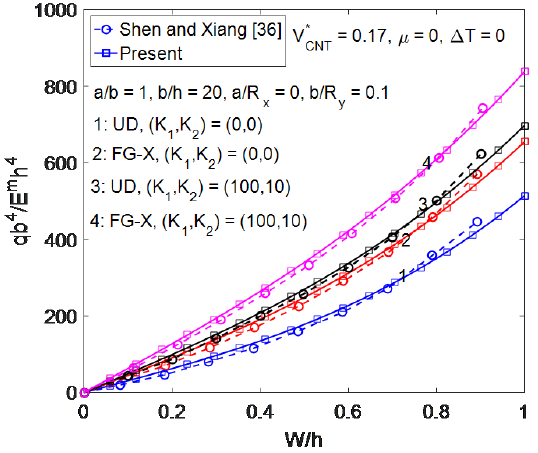
Fig. 2: Comparison of load-deflection response for CNTRC cylindri- cal panels with movable edges under uniform external pressure, ( m , n ) = (1, 1) .